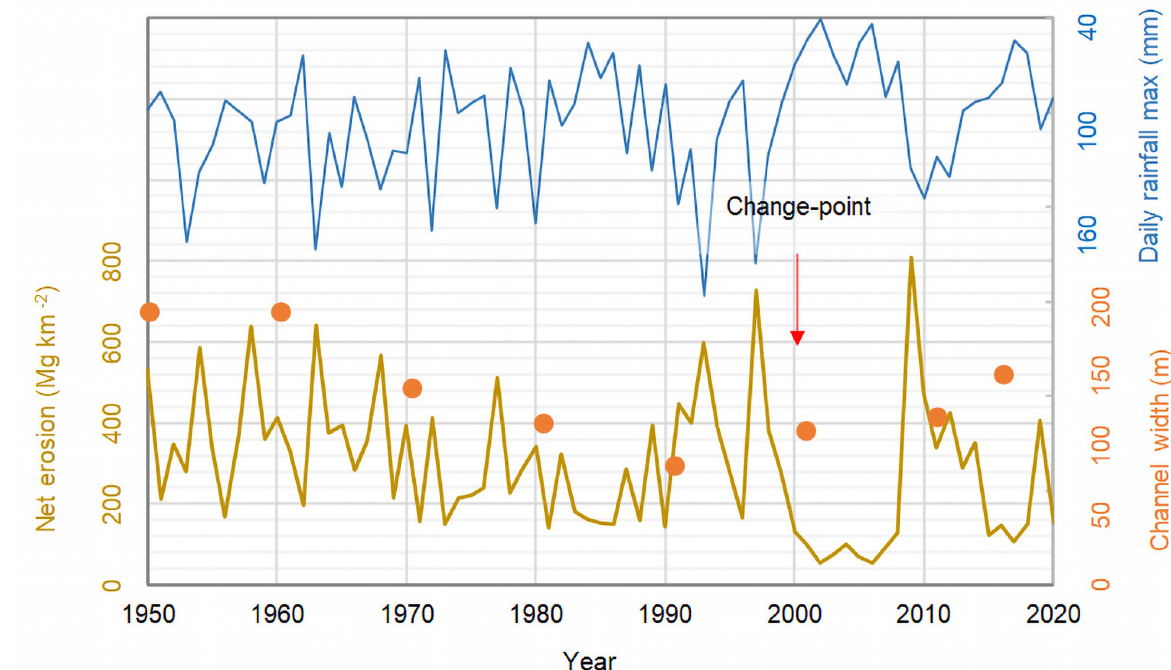
Fig 6. Evolution of annual net erosion for the Magra River Basin (ocher curve) during the period 1950–2020, as modelled by Eq (1), and overall pattern of changes in Magra channel width (orange dots; [27]). The annual maximum daily rainfall is also reported (blue curve).